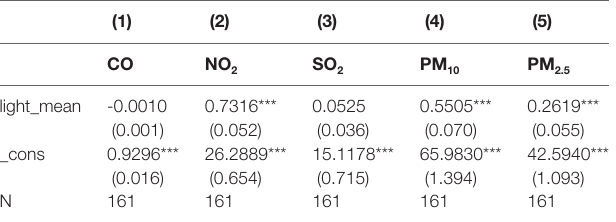
TABLE 3 | The impact of economic development on air pollutants without control